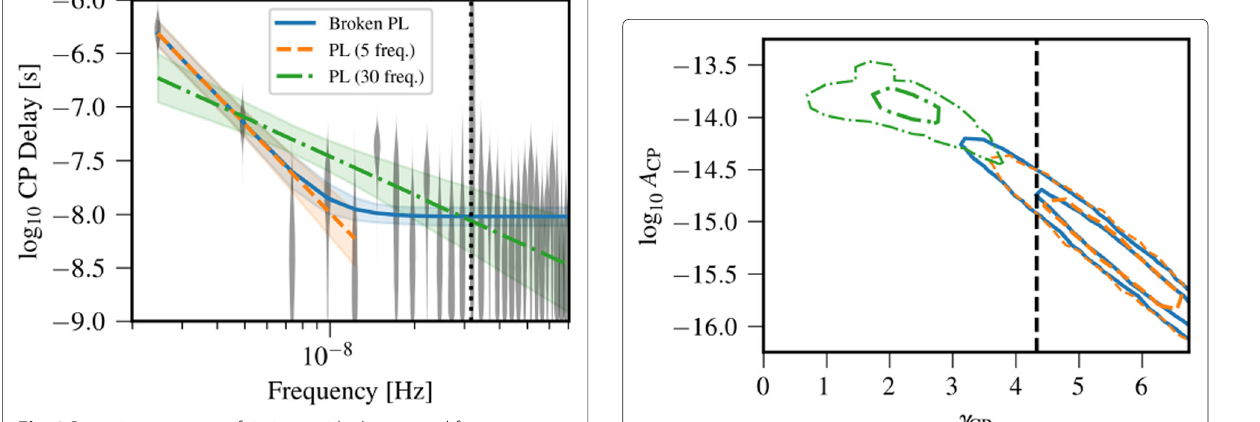
Fig. 3 Posterior spectrum of timing residual recovered from NANOGrav 12.5-year data with four models, namely, free spectrum (gray plots), broken power law (solid blue line), 5 lower frequency power-law fit (orange broken line), and 30 frequency power law fit (green dot-dashed line). Dotted vertical line marks the frequency f yr = 1yr − 1 . Reproduced from “The NANOGrav 12.5-year Data Set: Search for an Isotropic Stochastic Gravitational-wave Background” [30] by permission of the AAS